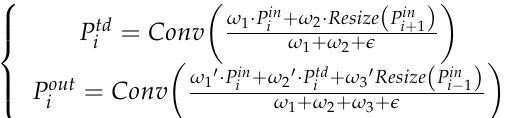
( b ) Figure 12. ( a ) Precision and recall plot of FPN + PANet; ( b ) precision and recall plot of BiFPN. In comparing Figure 12a,b it can be seen that after using BiFPN for ground penetrat- ing radar target detection, although the accuracy of YOLOv5 did not change much at nearly 0.8, the recall rate was improved by 0.1, which shows that the performance of ground penetrating radar target detection in BiFPN-YOLOv5 is better compared to